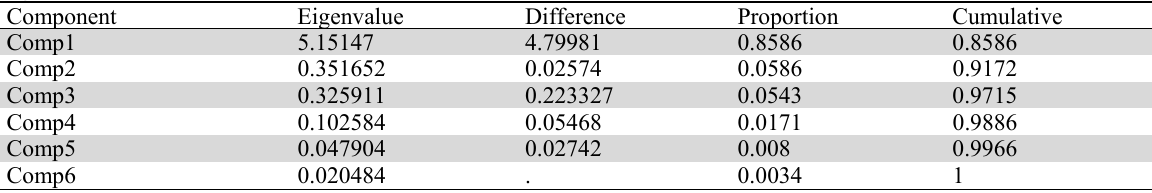
Eigenvalues of the correlation matrix Component